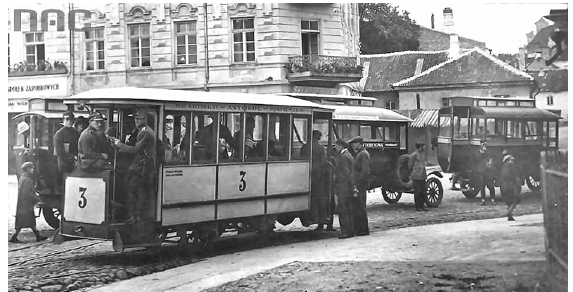
Fig. 6. The konkė coach improved by engineer